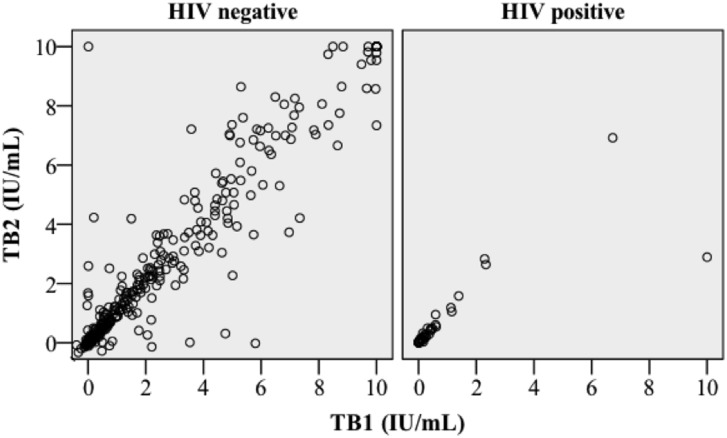
Association of TB1 and TB2 IFN-γ-levels.Scatter-plot of IFN-γ concentrations in TB1 and TB2 divided by HIV serostatus.